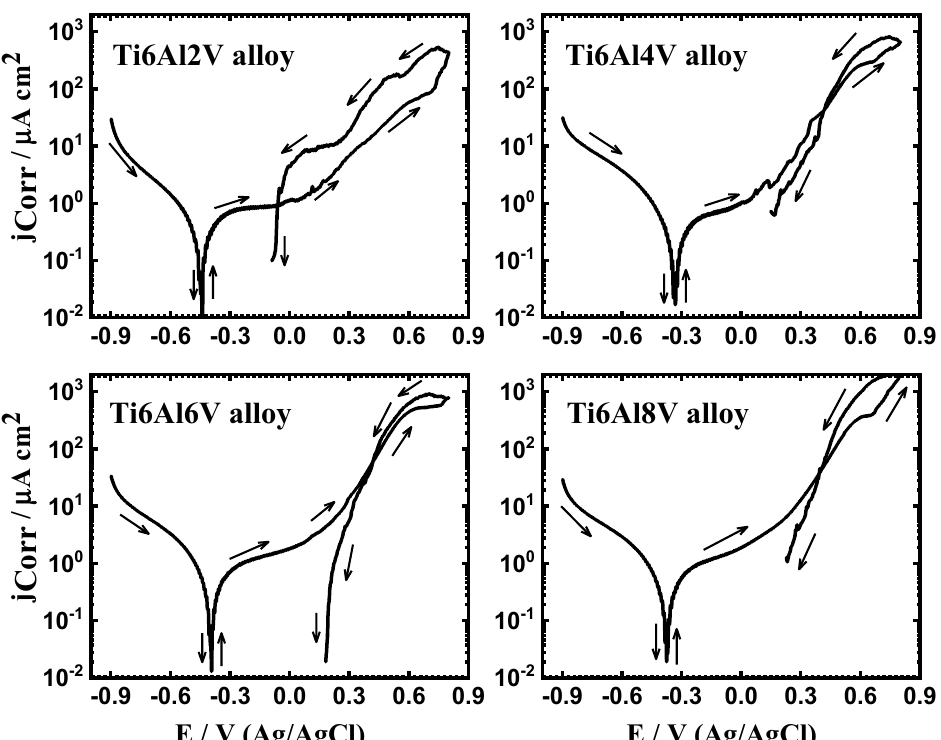
Figure6. TheCPPplotsrecordedfortheTiAlValloysaftertheirimmersionfor24hin3.5%NaClsolution. Figure 6. The CPP plots recorded for the TiAlV alloys after their immersion for 24 h in 3.5% NaCl solution.